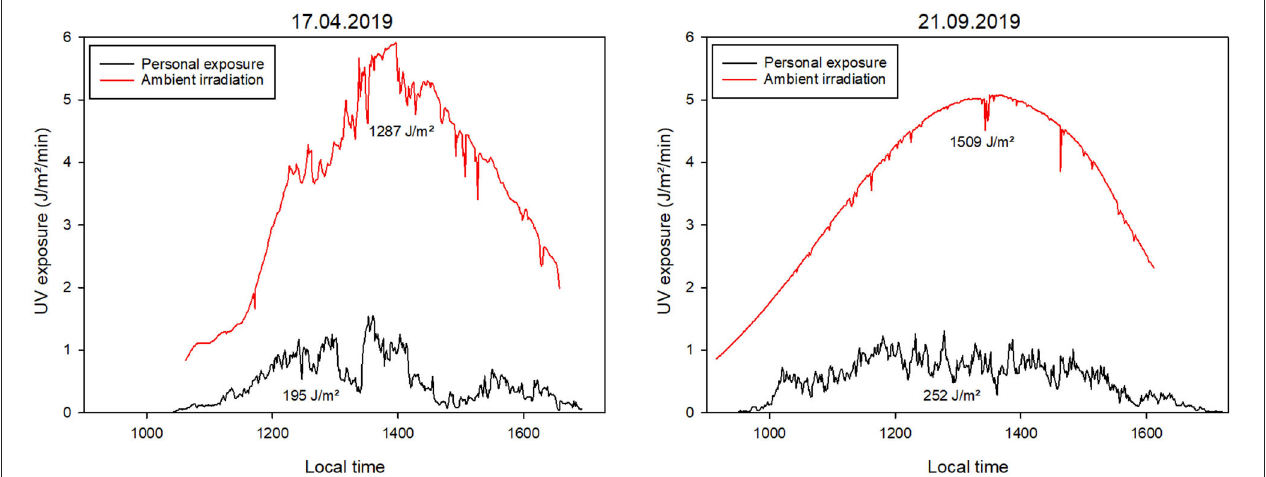
FIGURE 3 | Measurement data from the “visiting parks” activity from two different days. The red curves represent the ambient radiation on each day, measured with a separate dosimeter placed horizontally on a pedestal. The black curves represent the mean value of the personal exposure calculated from the 15 individual measurements. Also provided are total UV doses for ambient and personal measurements.